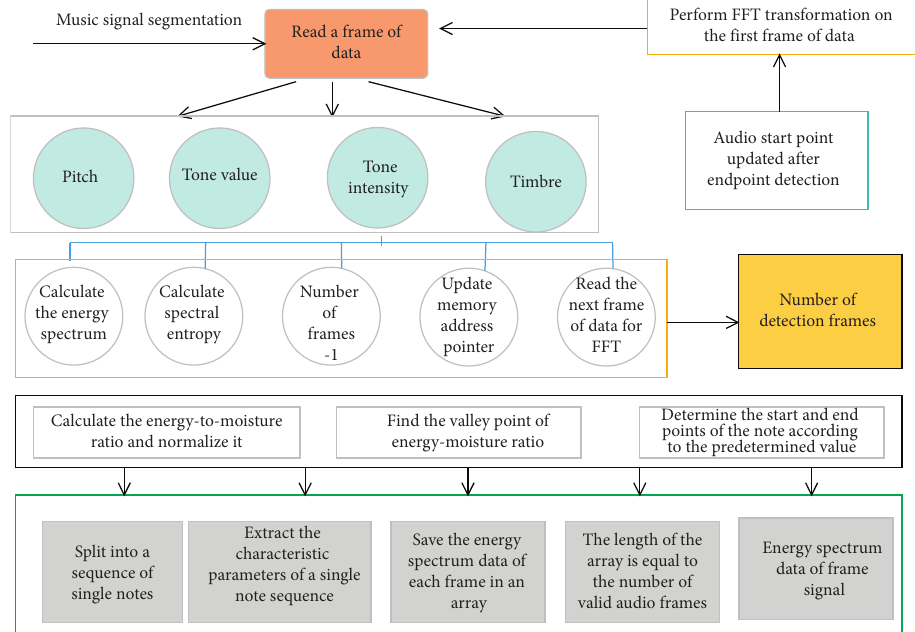
Figure 1: Schematic diagram of note time value